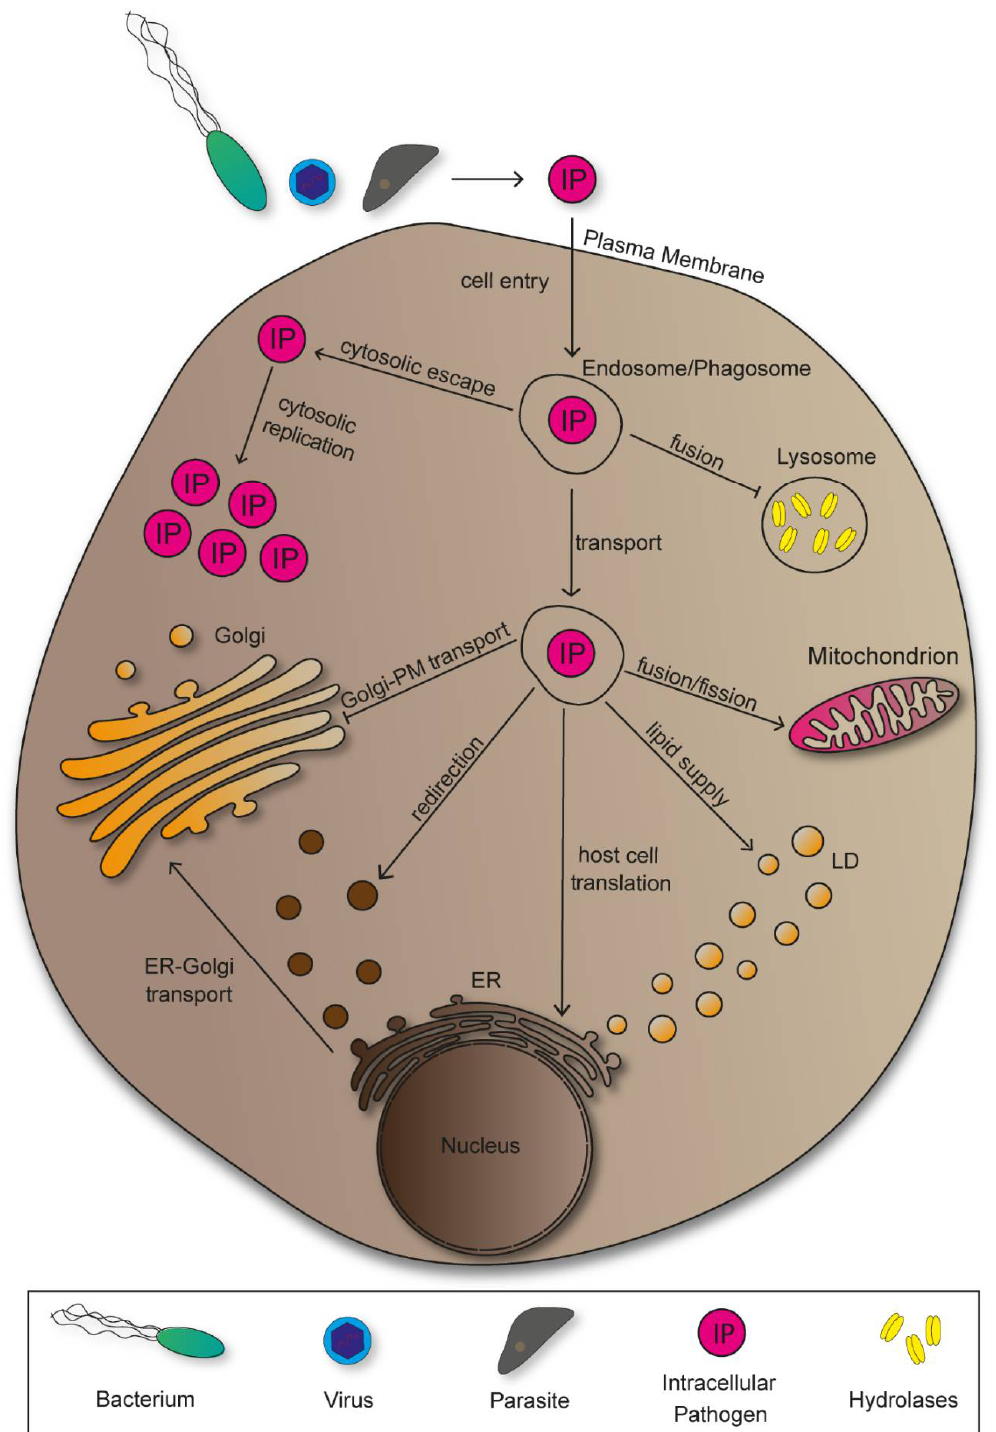
Figure 1. Membrane-bound organelles as targets of manipulation by intracellular pathogens. To initiate infection, intracellular pathogens manipulate the plasma membrane (PM) to enter host cells, or are phagocytosed. Subsequently, intracellular pathogens manipulate endosomes and phagosomes to either escape into cytoplasm, or for transport to further intracellular targets such as the endoplasmic reticulum (ER), the Golgi, mitochondria, or lipid droplets (LDs). The ER is mainly targeted by viral pathogens as they can exploit host cell ribosomes for protein synthesis. Manipulations targeting the Golgi often include disruptions of the secretory pathway. Mitochondria, as energy-generating organelles, are exploited to either decrease or increase cellular energy levels, with both processes promoting proliferation of distinct pathogens. LDs are mainly targeted by pathogens to utilize their lipid content as nutritional supply. However, viruses are able to utilize the vesicles for cellular